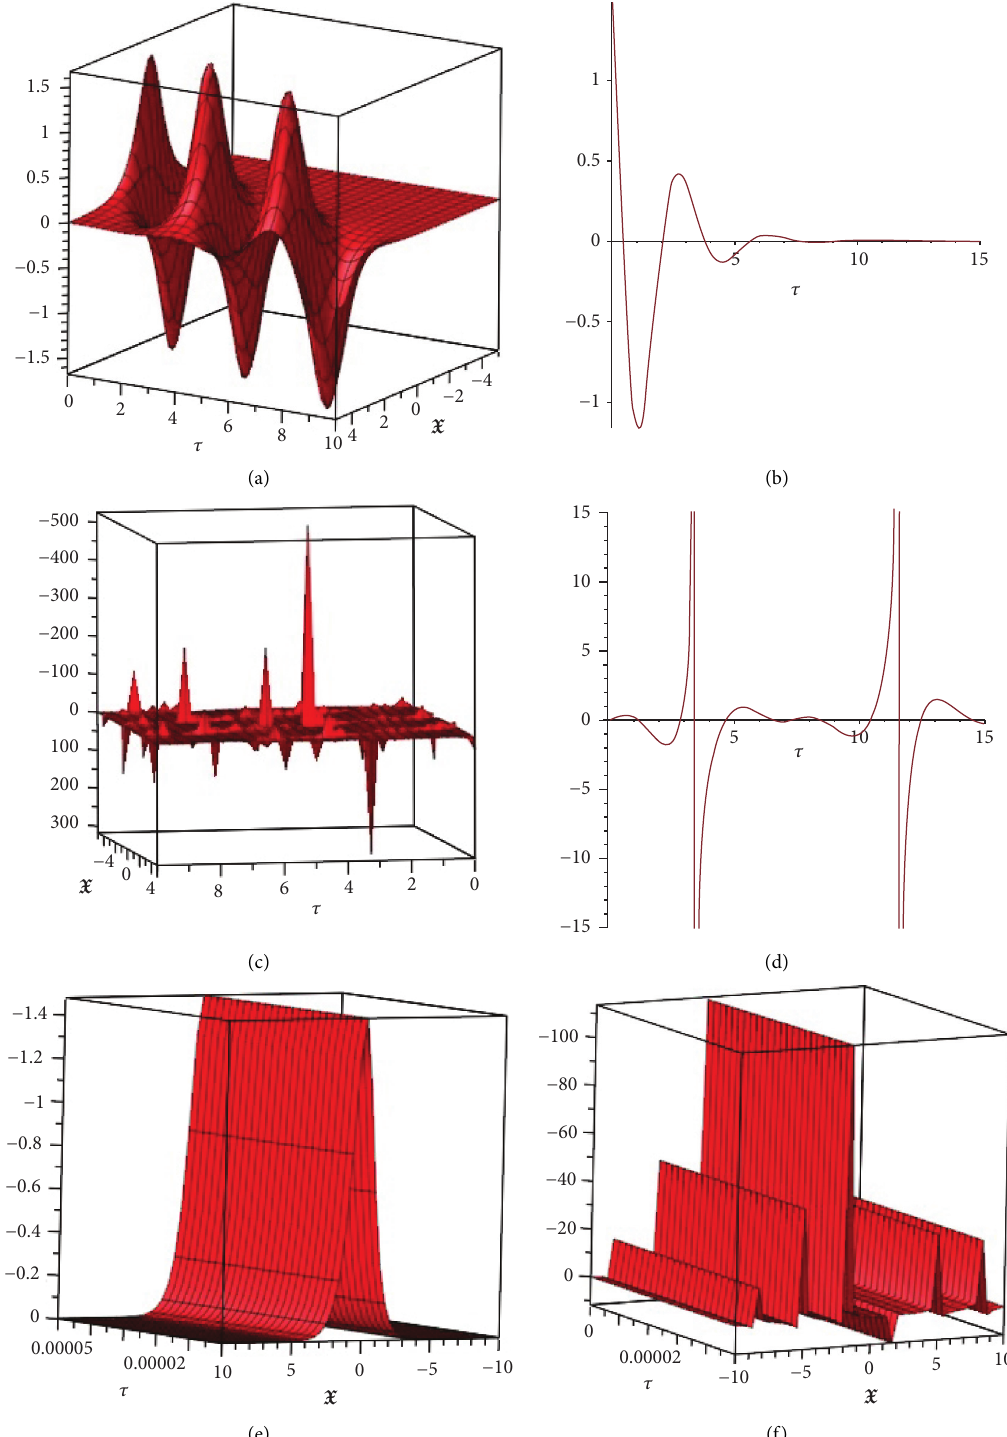
Figure 7: (a, e, b) 3D and 2D with the real part of solutions Ψ and 2D with the real part of solutions Ψ